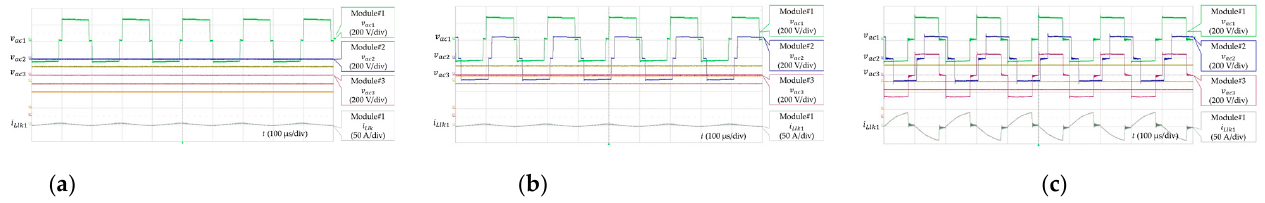
Figure 22. The startup and shutdown process of Module#1. ( a ) Startup process; ( b ) Shutdown process.